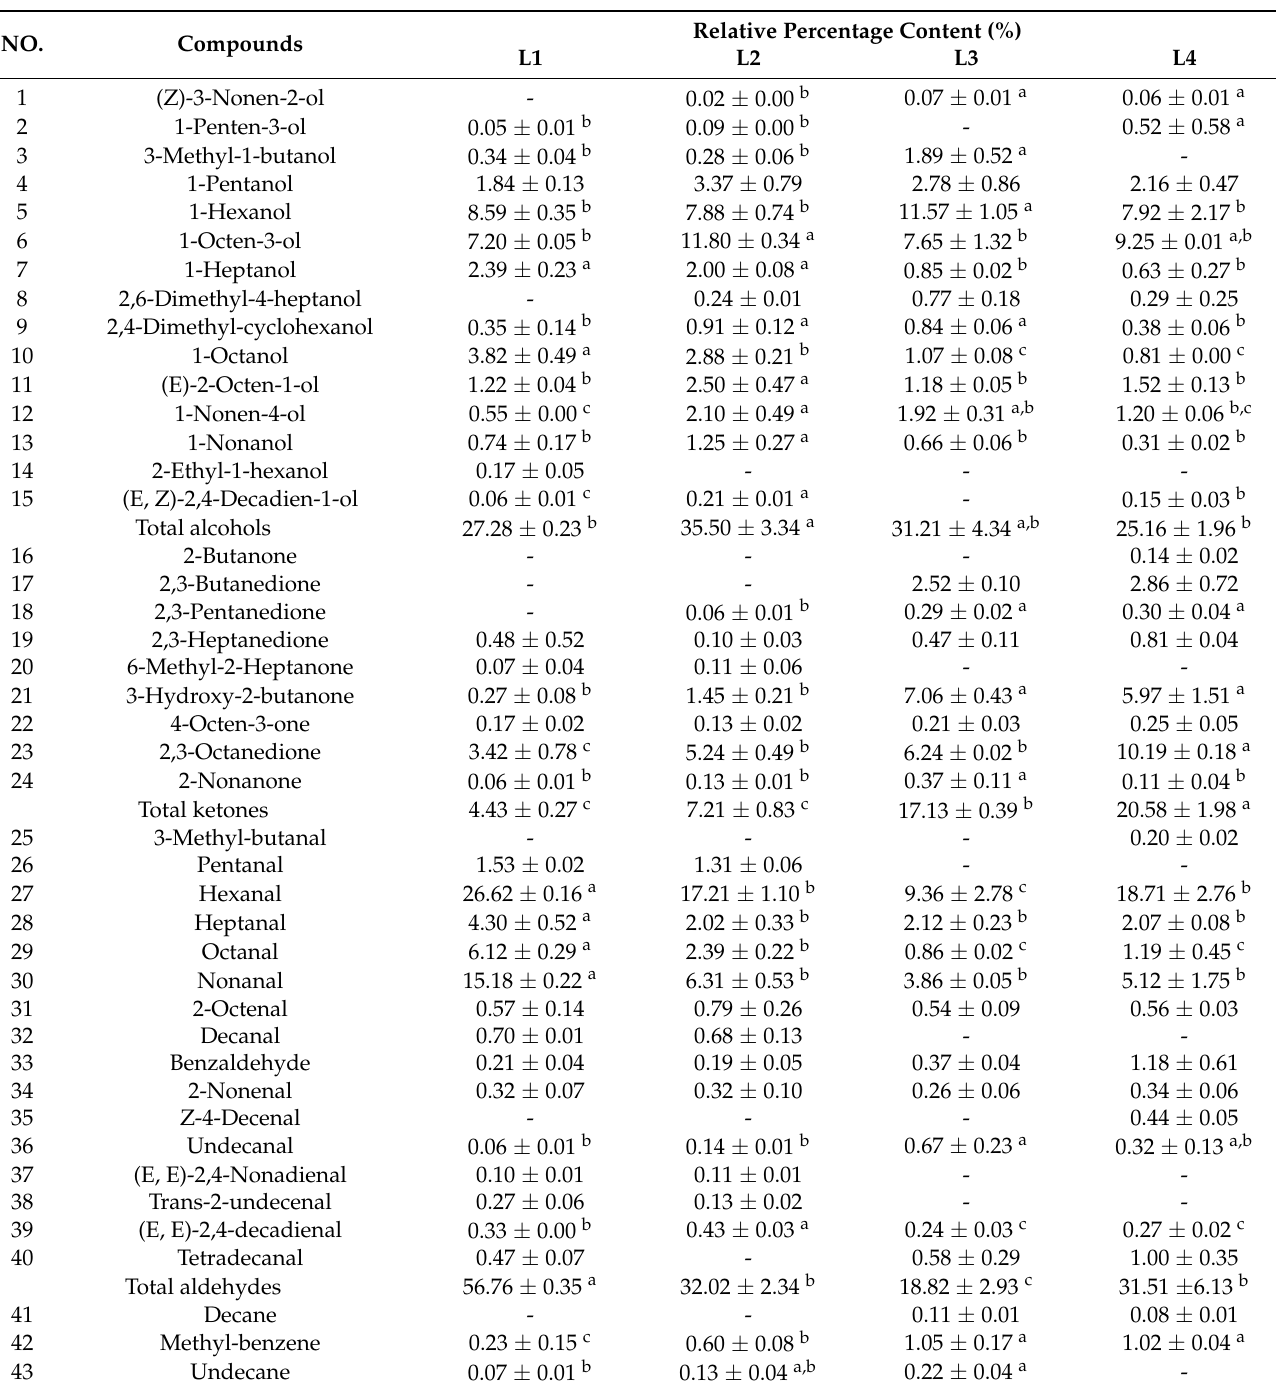
Table 1. Volatile compounds at different processing stages of Daokou braised